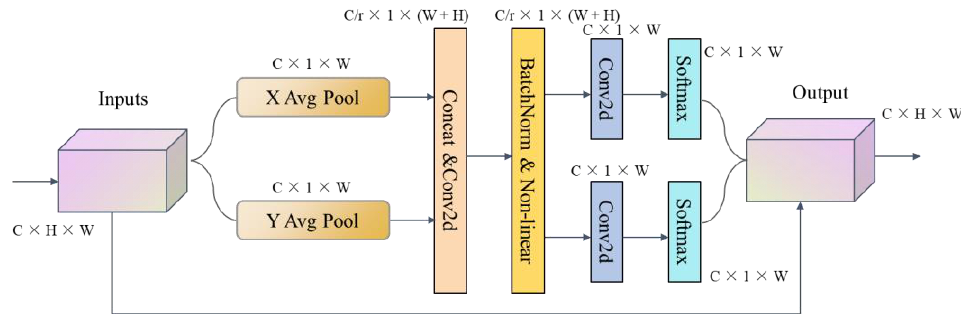
Figure 2. Schematic diagram of the CA mechanism module.